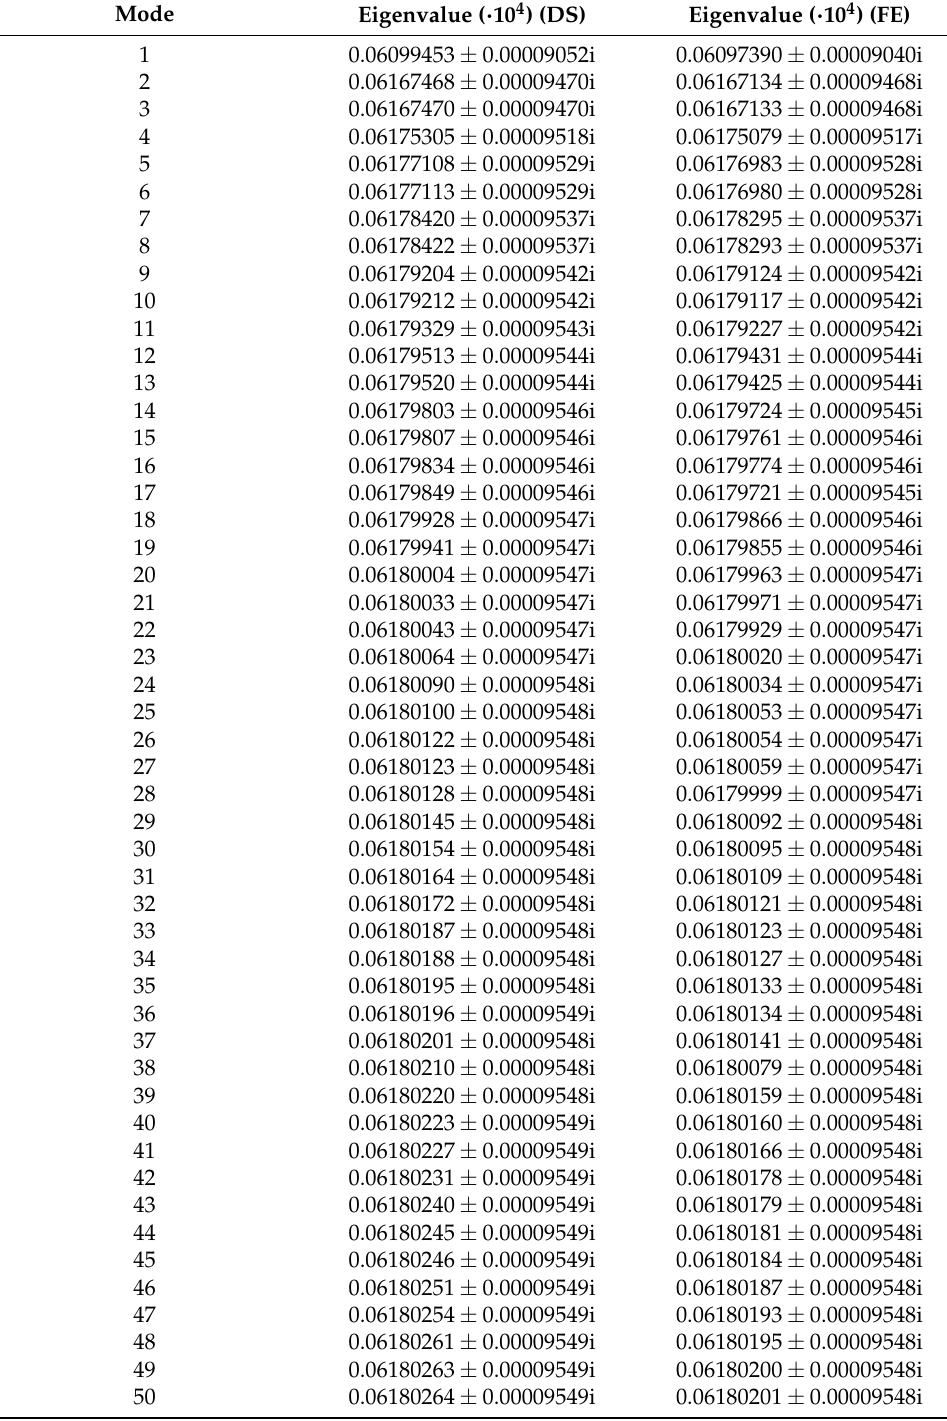
Table A1. Complex eigenvalues (from 1 to 50) of the LRMP in Figure 3 with 2-DOF resonators, computed by means of the proposed dynamic-stiffness approach (DS) and the FE method